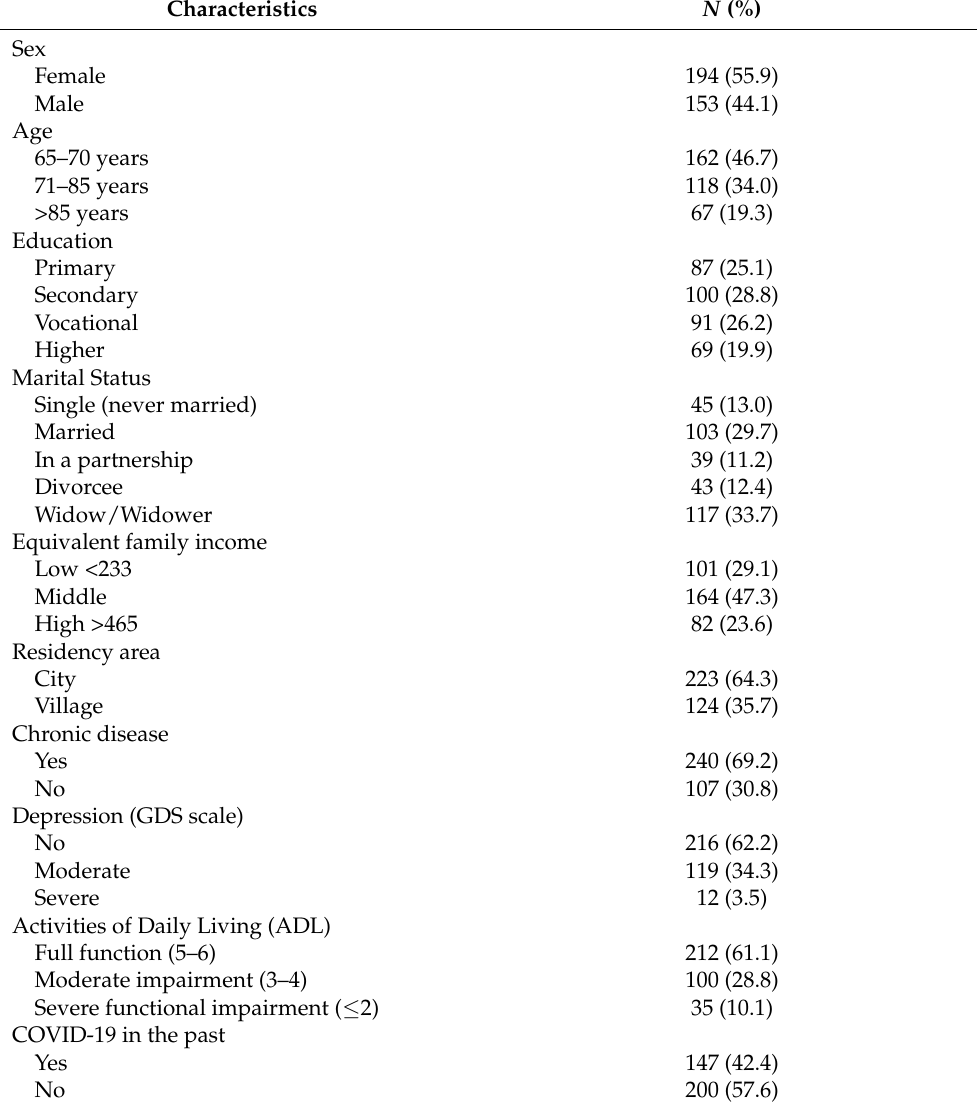
Table 1. Descriptive